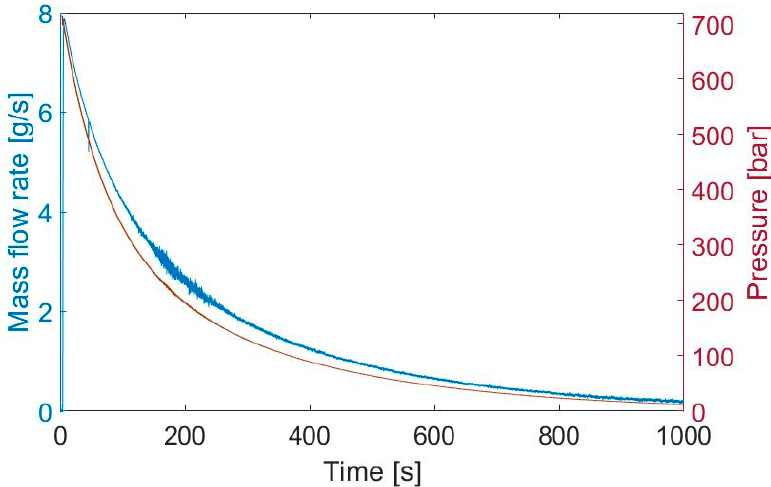
Figure 7. Mass flow rate and pressure at the tank measured during Exp. 20: 700 bar.